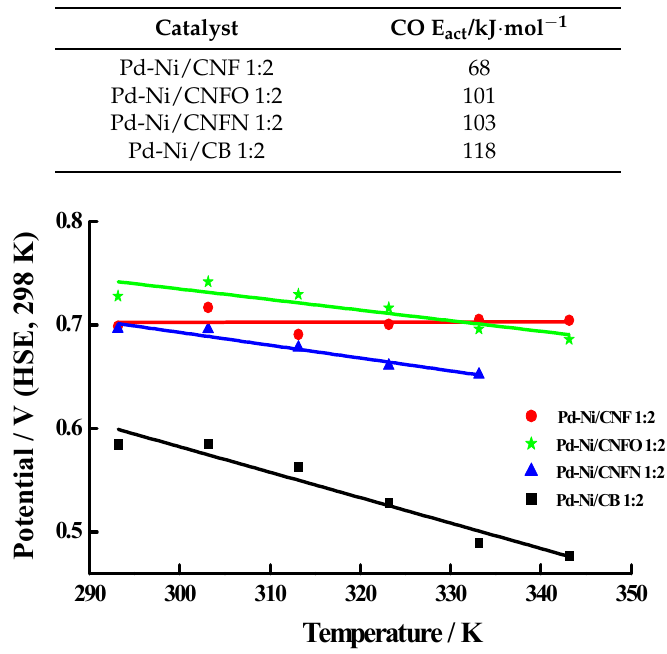
Figure 8. CO oxidation peak potential vs. temperature for the synthesized Pd ‐ Ni catalysts.